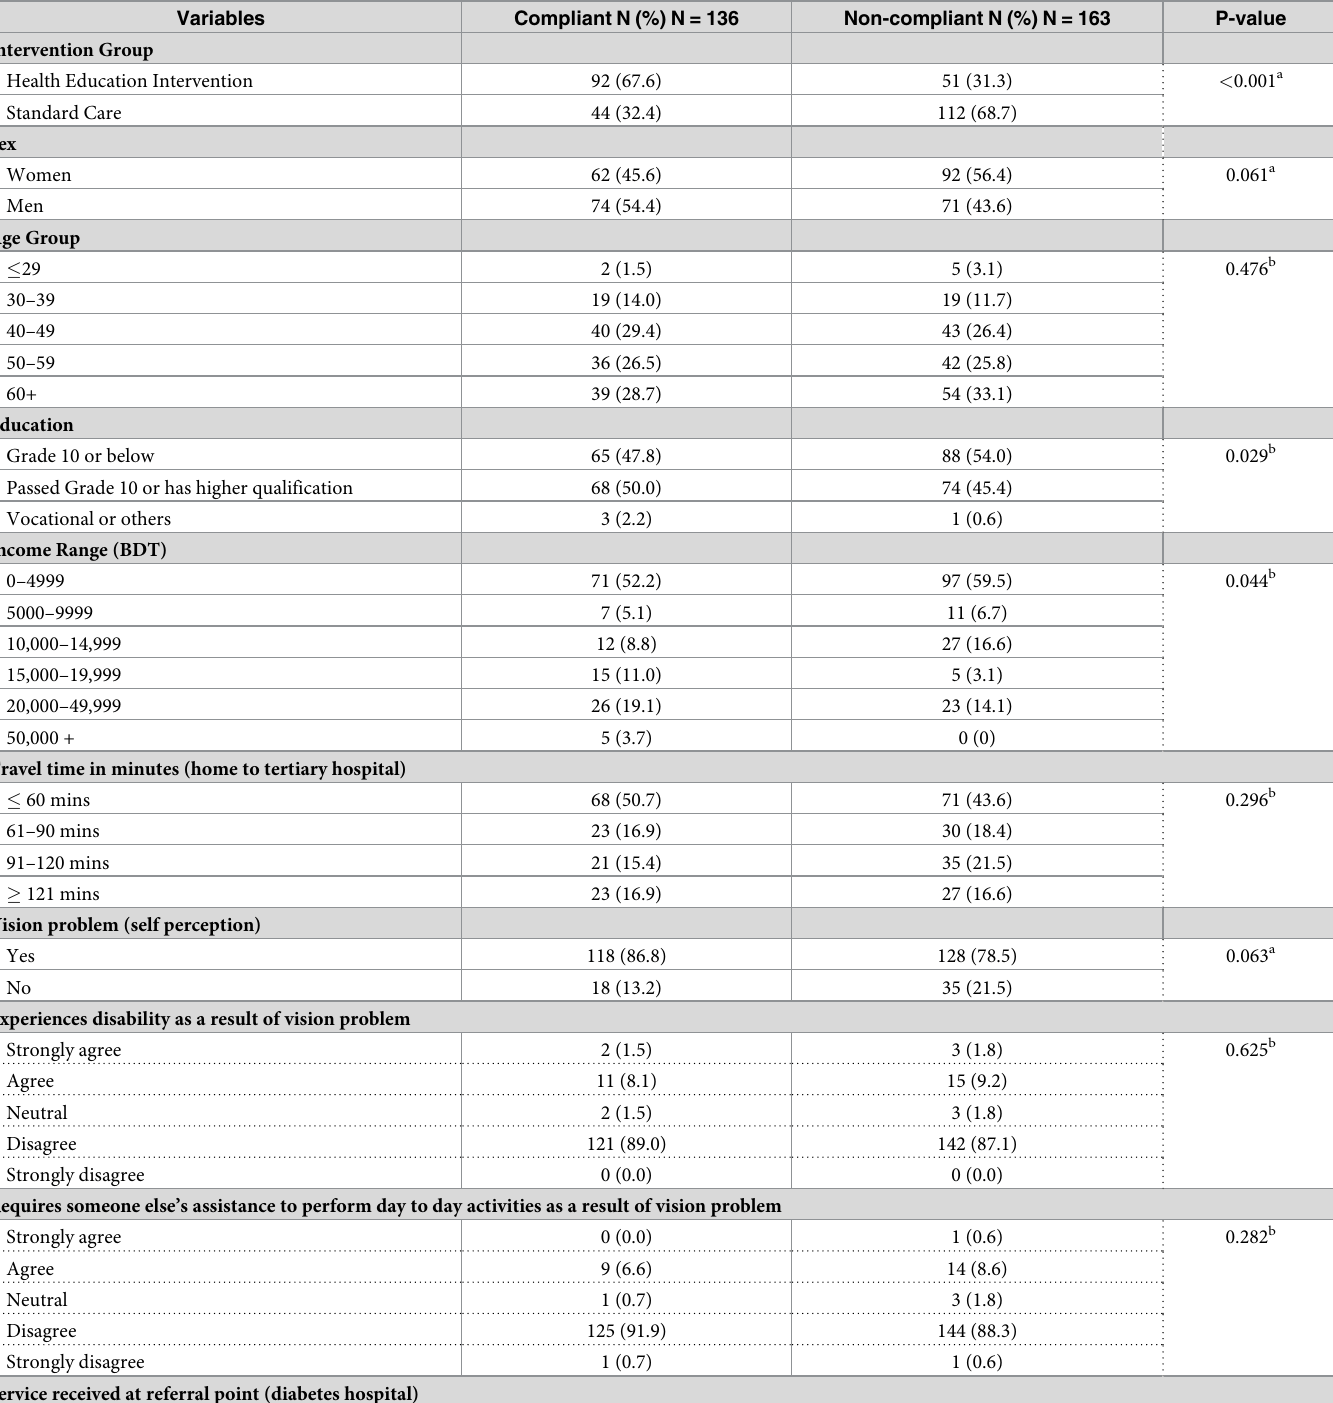
Table 5. Association of primary outcome with other